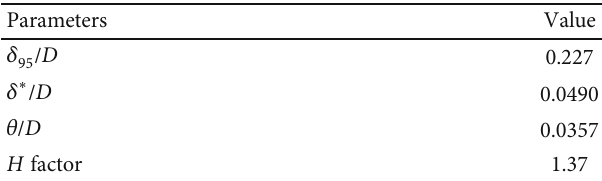
Table 2: Characteristics of boundary